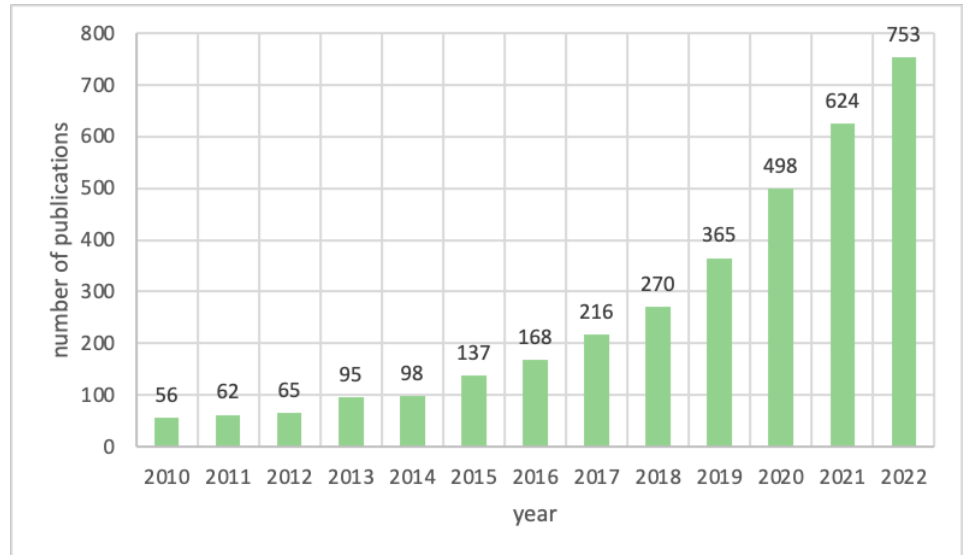
Figure 1. Numbers of publications mentioning PA-derived carbon materials over the last 10 years, according to the ScienceDirect database.